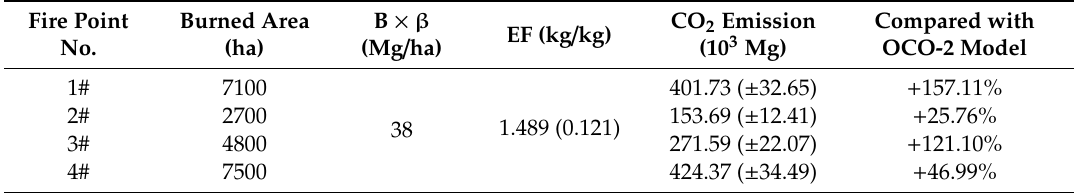
Table 2. CO 2 emission values and calculated parameters for each fire scar using the